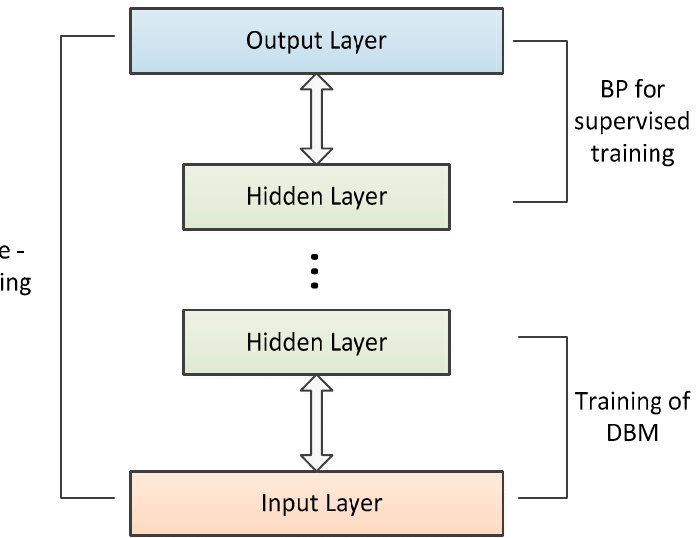
Figure 3. Training process of deep belief network.